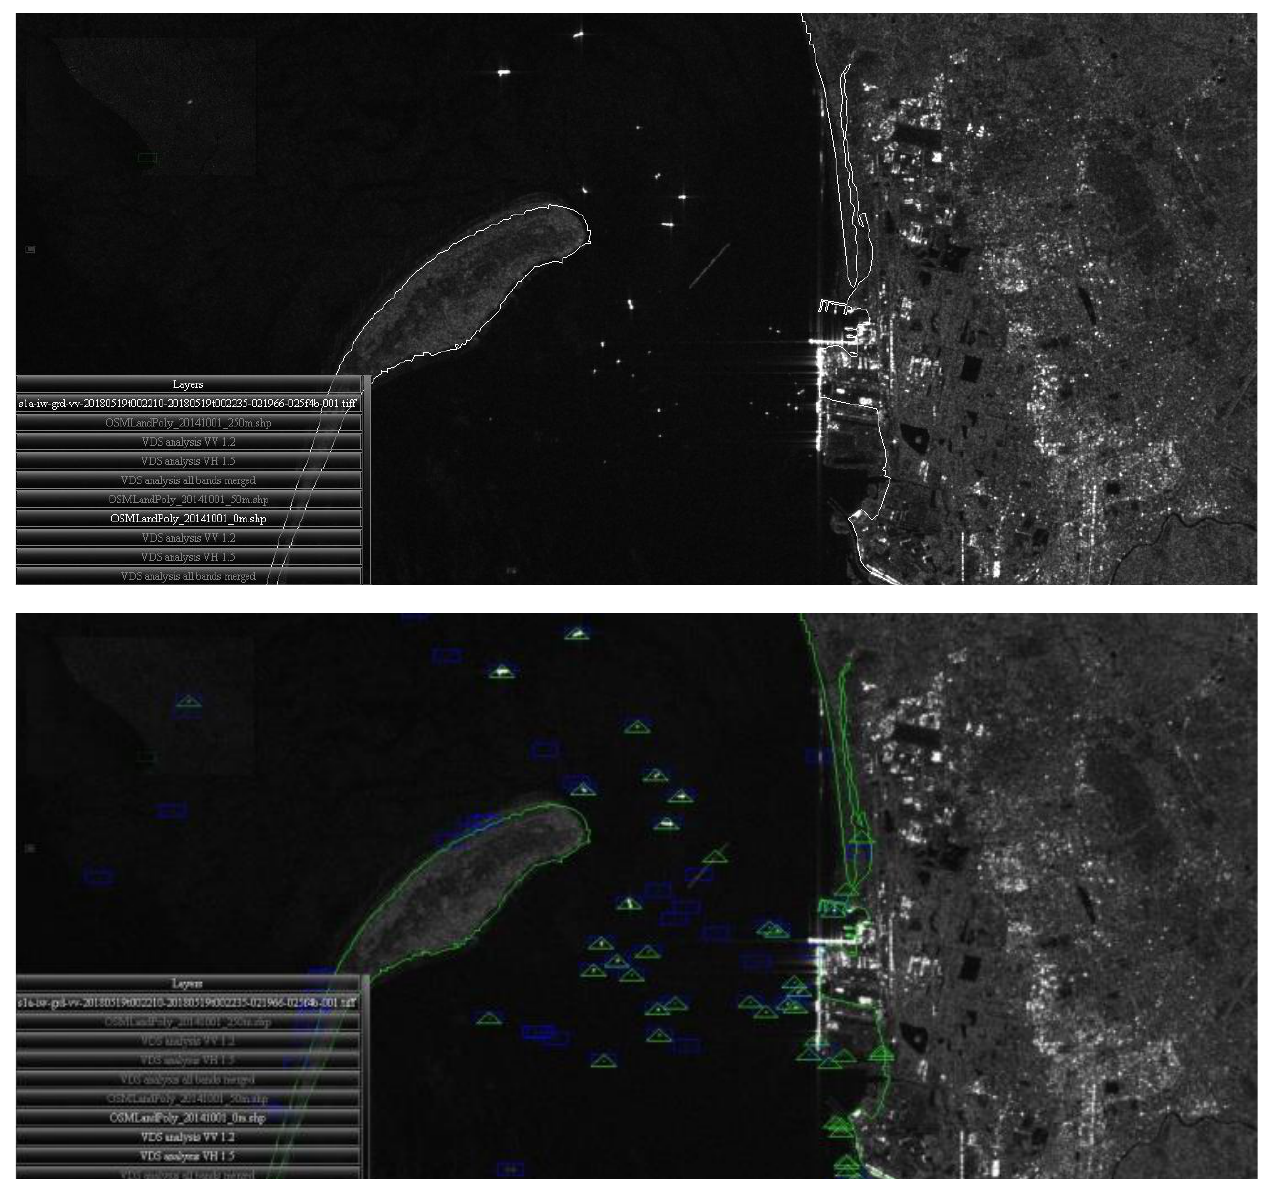
Fig.5 SUMO ship detection results on the port of Kakinada, Hope Island. The image is loaded with the land mask with sea buffering by 0m (above) and the detection depicted by different shapes (below). Blue rectangle denotes the detection in VV polarization and green triangle denotes the detection in VH polarization